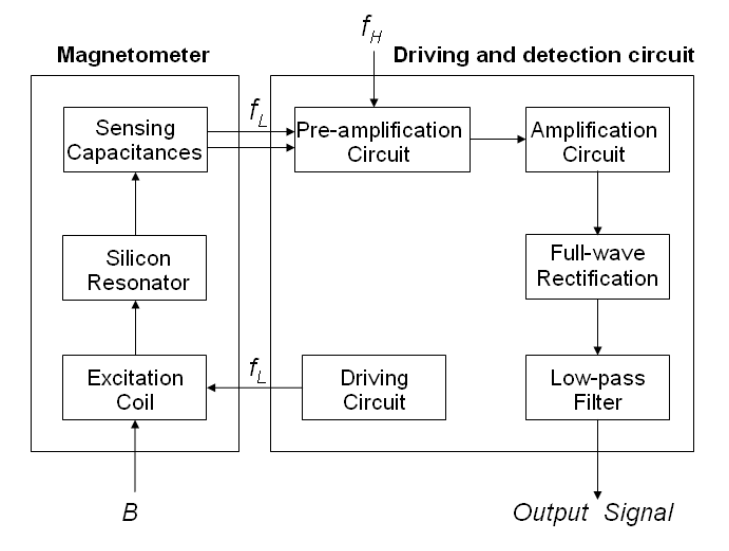
Figure 14. The schematic block diagram of the driving and detection circuit.